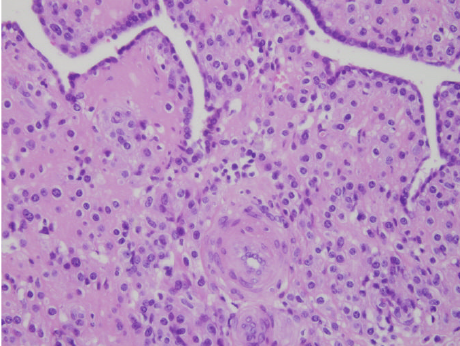
Figure 3: Histological findings of the tumor. The tumor was composed of solid cell sheets containing tubular architectures.